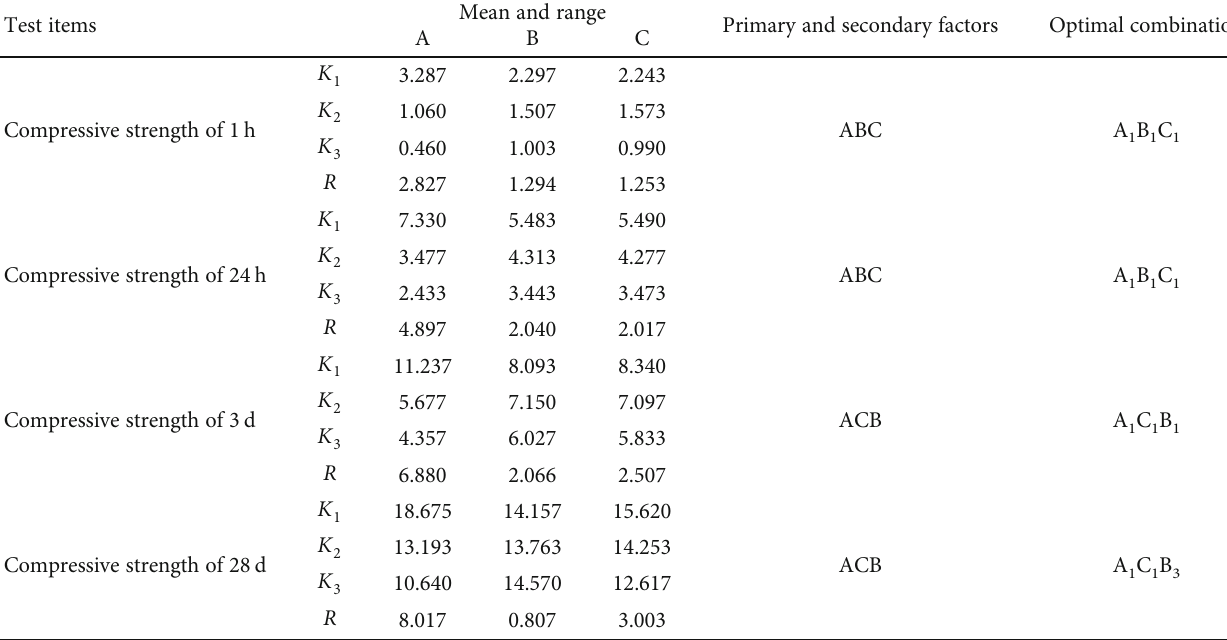
Table 6: Range analysis table of mechanical properties of slurry stone.